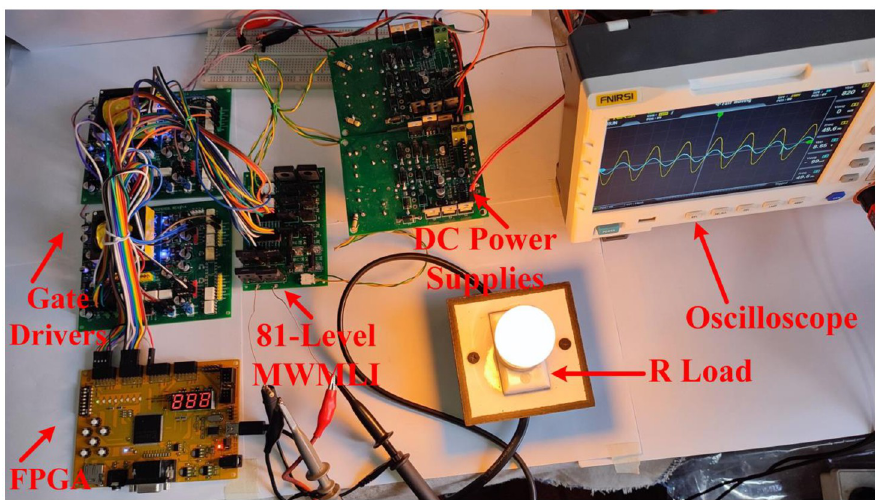
Fig 21. Hardware prototype for the 81-level MWMLI.